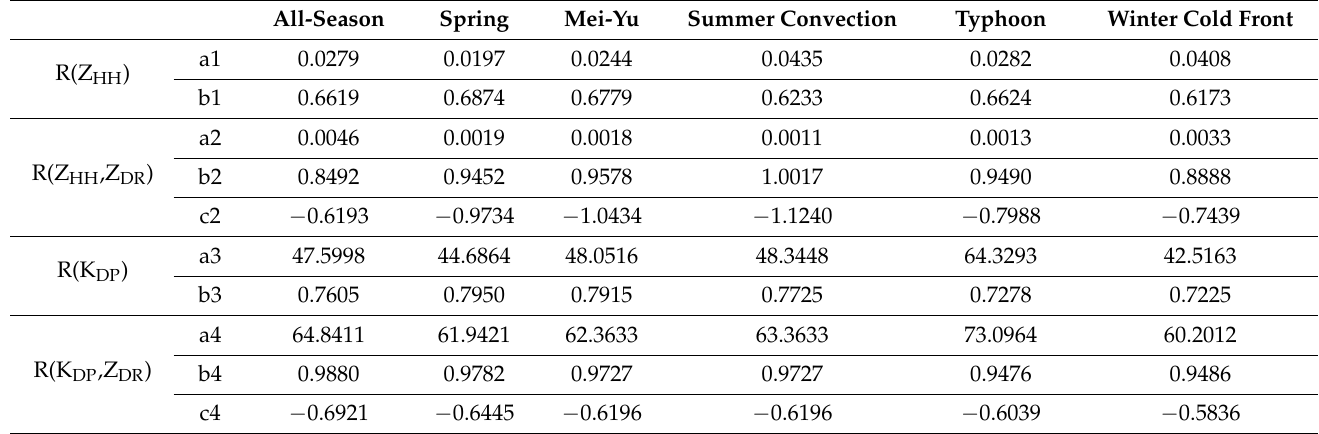
Table 2. The coefficients of four power-law rain rate relations for S-band radar. The all-season coefficients are derived from the entire database measured by a 2D-Video Disdrometer (2DVD) at National Central University (NCU). The seasonal coefficients are classified into spring, Mei-Yu, summer convection, typhoon, and winter cold front.